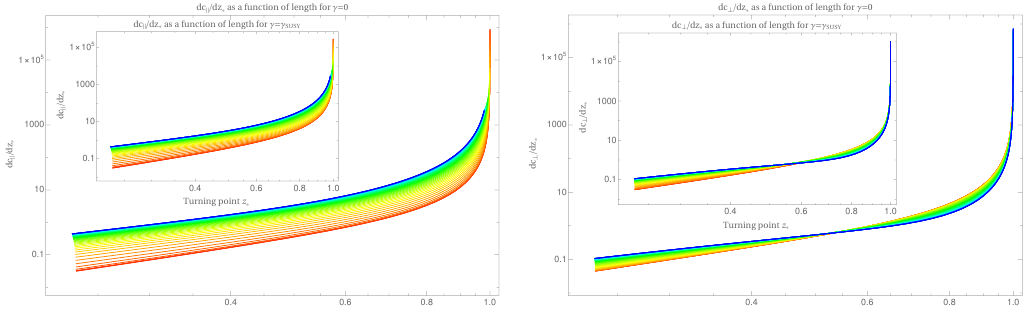
Figure 19 . The slope of the c-function with respect to the bulk turning point z ∗ , which encodes the energy scale of the system. Left: dc /dz ∗ . Right: dc ⊥ /dz ∗ . In both images the inset graphic || displays the same result at γ = γ SUSY . In addition both images are displayed at µ/T = 1 / 5 for B/T 2 varying from B/T 2 = 1 . 00 to B/T 2 = 500 . 00 . In both cases we see that dc/dz ∗ ≥ 0 and hence c and c ⊥ are monotonic functions of ‘ or equivalently of z ∗ , whose monotonous relation is || given in figure